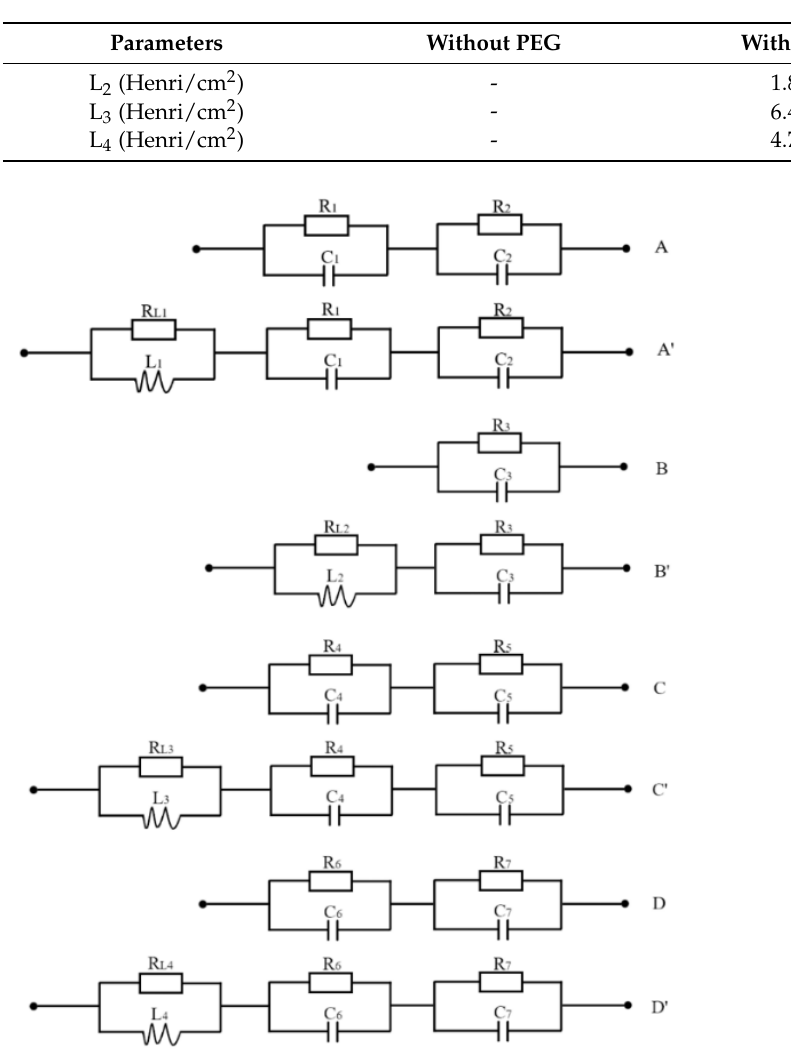
Figure 4. Equivalent circuits of the EIS in Figures 2 and 3. Circuits A, A ′ , B, B ′ , C, C ′ , D, and D ′ correspond to curves A, A ′ , B, B ′ , C, C ′ , D, and D ′ in Figures 2 and 3. R 1 , R 2 , R 3 , R 4 , R 5 , R 6, and R 7 , C 1 , C 2 , C 3 , C 4 , C 5 , C 6, and C 7 : the electrochemical reaction resistances and double layer capacitances of Equations (2), (6)–(11); L 1 , L 2 , L 3 and L 4 , R L1 , R L2 , R L3, and R L4 : the inductance and resistance caused by adsorption and desorption of PEG. Table 2. Related parameters in Figure 4.